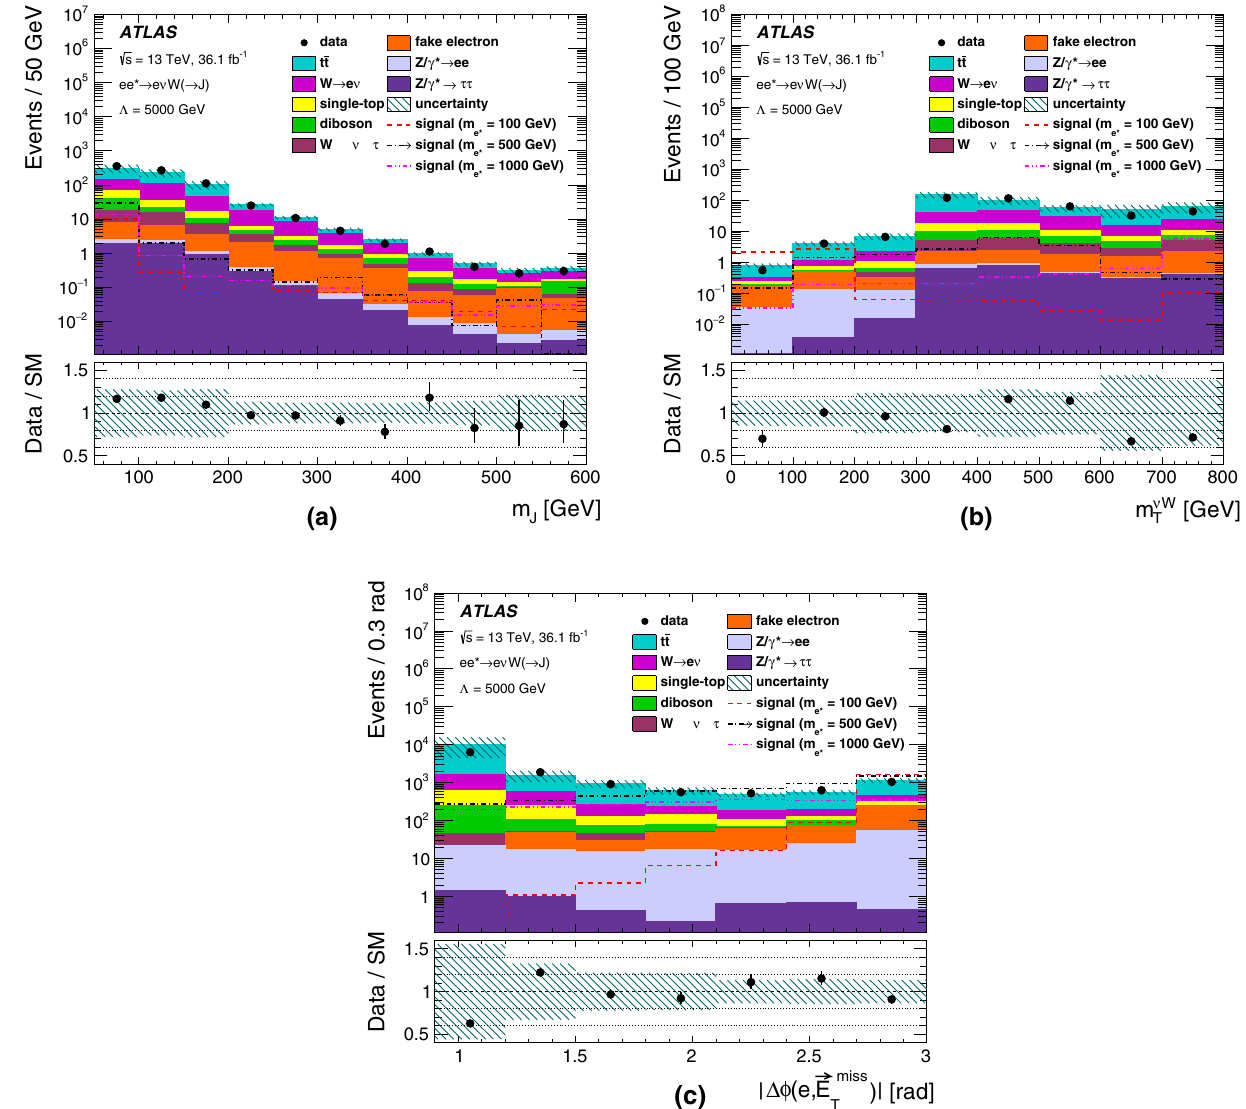
(cid:7) (cid:7) (cid:7) (cid:7) ) (cid:7) (cid:5)φ( e , (cid:9) E miss (cid:7) used , and c (the underflow is not shown). The ratio of the number of data events to T T the expected number of background events is shown with its statistical uncertainty in the lower panes. The hashed bands represent all consid- ered sources of systematic and statistical uncertainties for the expected